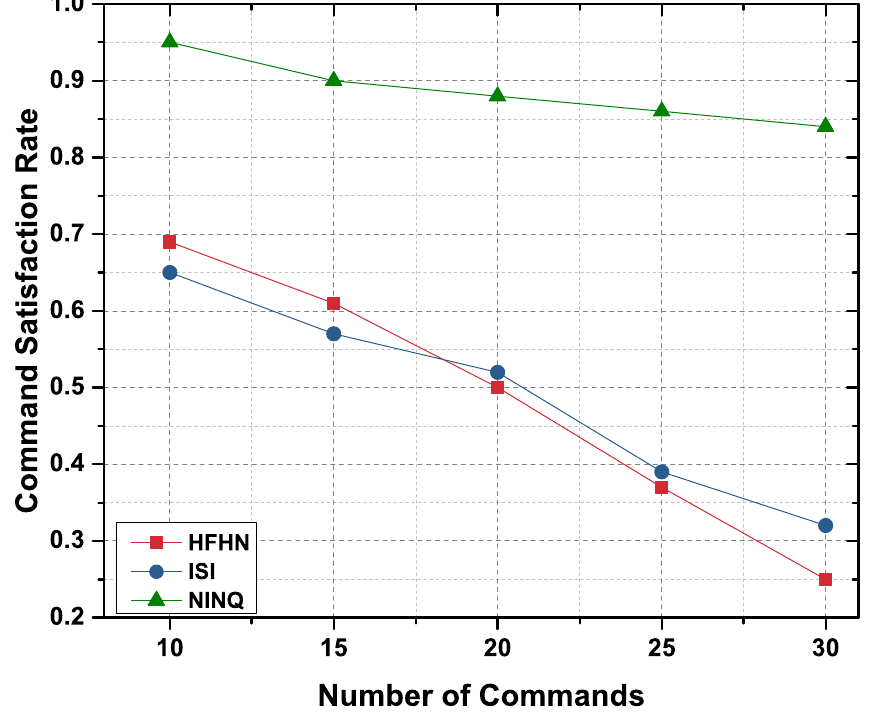
Figure 12. CSR in a network by number of